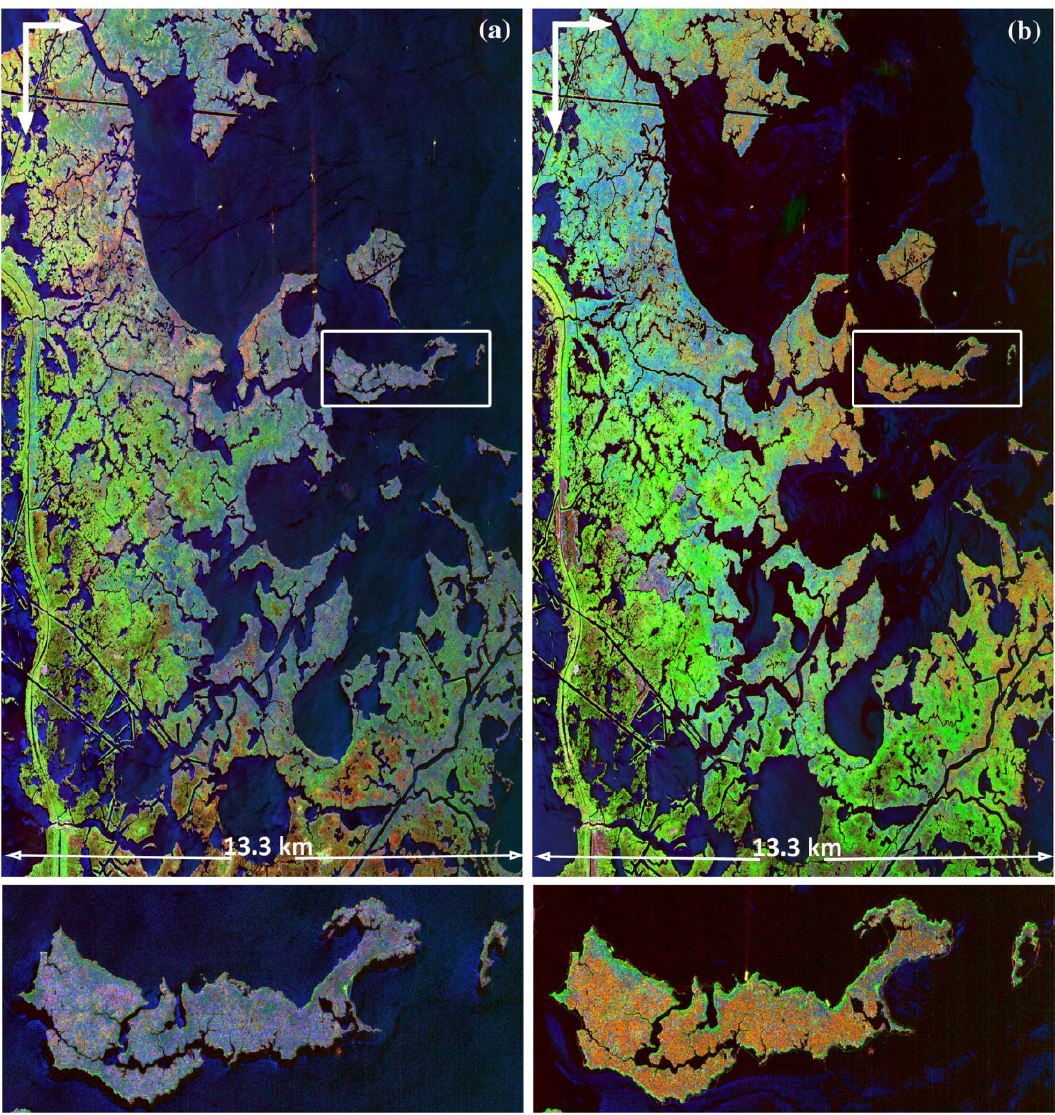
Figure 9. Results of the Freeman-Durden (FD) decomposition of the 2009 (a) and 2010 (b) MLC data of the MRD flight lines. Colors depict dominant fractions of surface (blue), volumetric (green), and double-bounce (red) backscatter. The same color reference table was used in 2009 and 2010